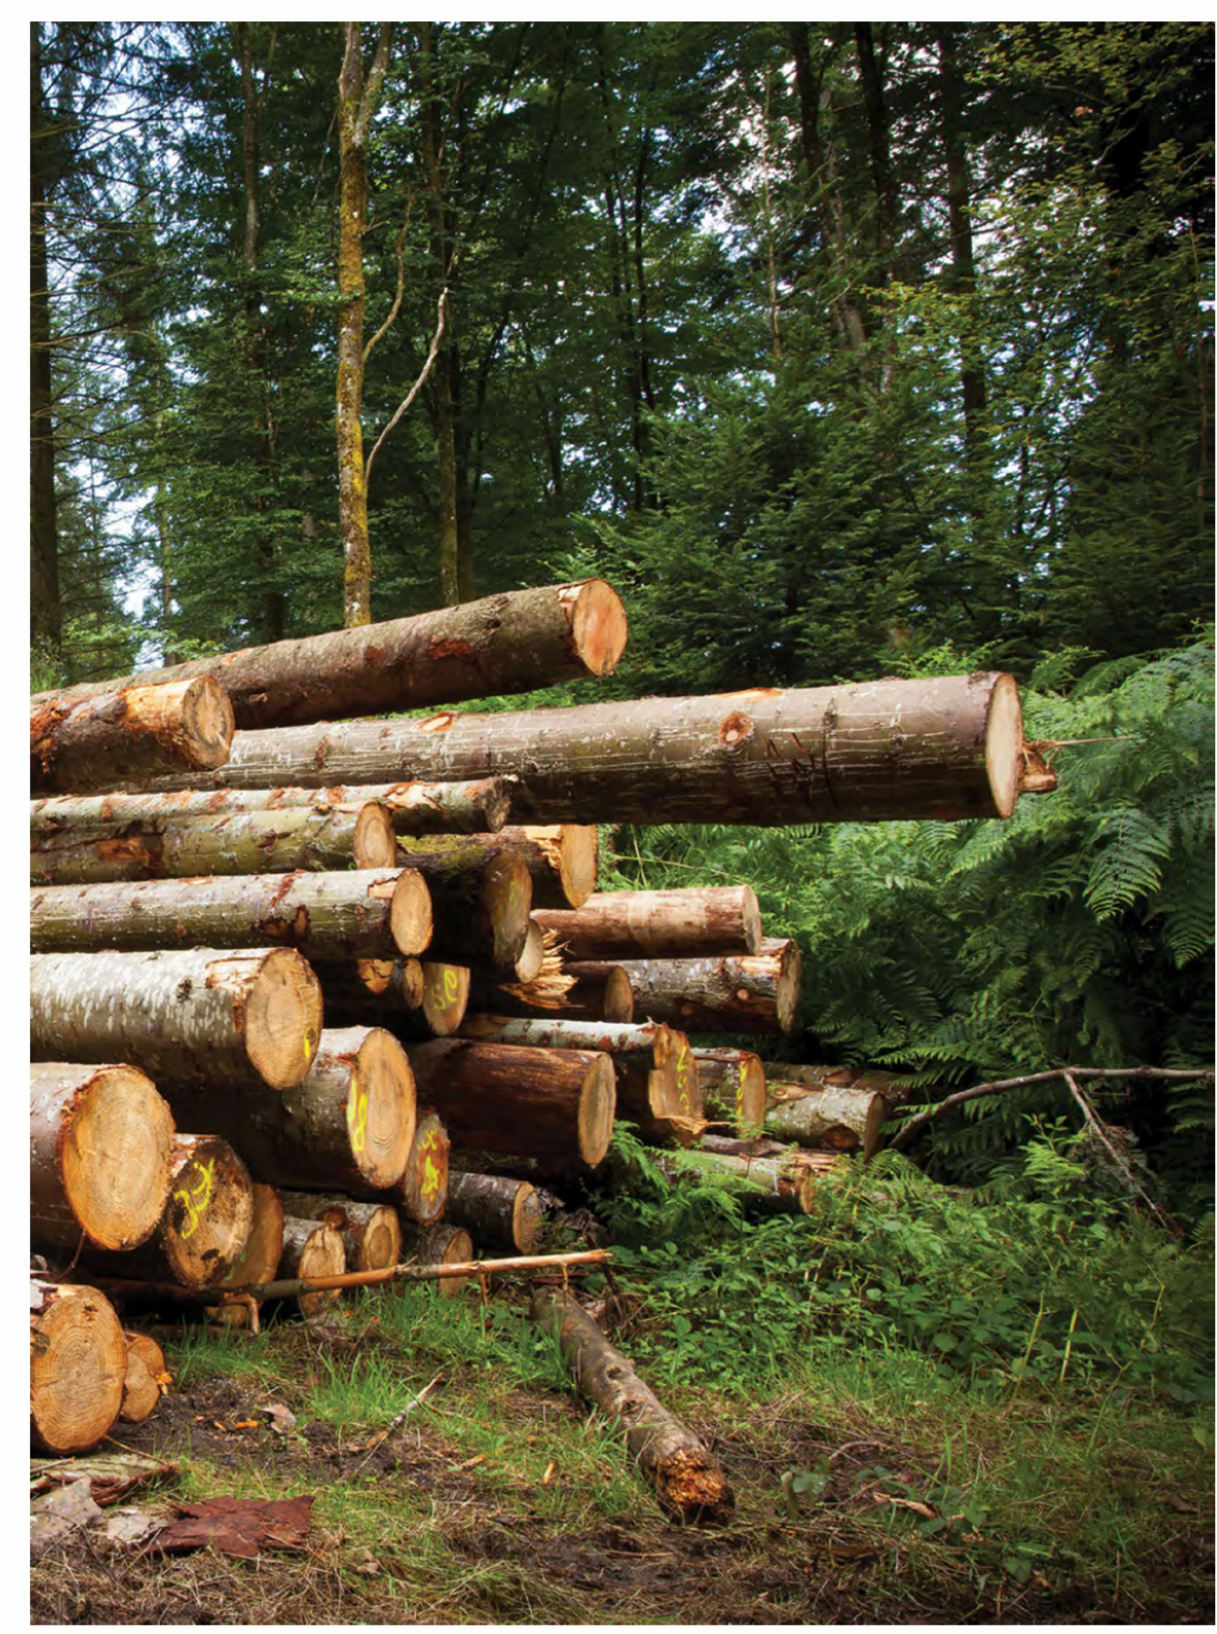
Figure 6. Trees extracted from the forest to make poles for construction